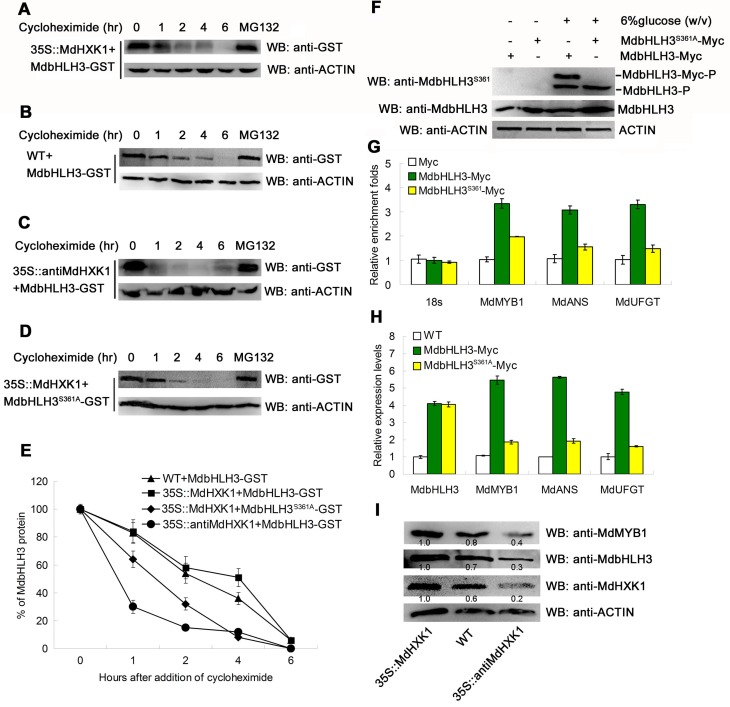
Phosphorylation modification stabilizes the MdbHLH3 protein and enhances its binding capacity to the promoters of downstream genes.(A-C) Cell-free degradation assays demonstrate that MdHXK1 stabilizes the MdbHLH3 protein. The recombined MdbHLH3-GST protein was co-incubated with the isolated total proteins extracted from the WT control (B) and the 35S::MdHXK1
(A) and 35S::antiMdHXK1
(C) transgenic apple calli. In addition, the mixed proteins were treated with 20 μg /mL cycloheximide for 0, 1, 2, 4 or 6 h. The degradation of MdbHLH3 protein was measured using Western blotting with an anti-GST antibody. MG132 was used as a positive control to stabilize the MdbHLH3 protein unless noted otherwise. (D) Ser361 is important for the MdHXK1-mediated stabilization of MdbHLH3. (E) The graph shows the quantitation of the Western blot data in (A), (B), (C) and (D). (F) Western blotting assay of the phosphorylation intensity for MdbHLH3 and MdbHLH3S361A proteins in MdbHLH3-Myc and MdbHLH3S361A-Myc transgenic calli. The anti-MdbHLH3S361 antibody was used. (G) ChIP-qPCR assays of the enrichments of the target gene promoters in the 35S::MdbHLH3-Myc and 35S::MdbHLH3S361A-Myc transgenic calli compared to the 35S::Myc transgenic calli. (H) Relative expression levels of MdMYB1, MdANS and MdUFGT in the WT control and in the 35S::MdbHLH3-Myc and 35S::MdbHLH3S361A-Myc transgenic calli. (I) Protein abundance of MdHXK1, MdbHLH3 and MdMYB1 in the WT control and in the 35S::MdHXK1 and 35S::antiMdHXK1 transgenic apple calli. Protein amounts were normalized based on the protein folds of the 35S::MdHXK1 transgenic apple calli. In (G) and (H), the data are shown as the mean ± SE, which were analyzed based on more than 9 replicates. Statistical significance was determined using Student’s t-test in different apple calli lines. n.s., P > 0.01; *P < 0.01; **P < 0 .001.